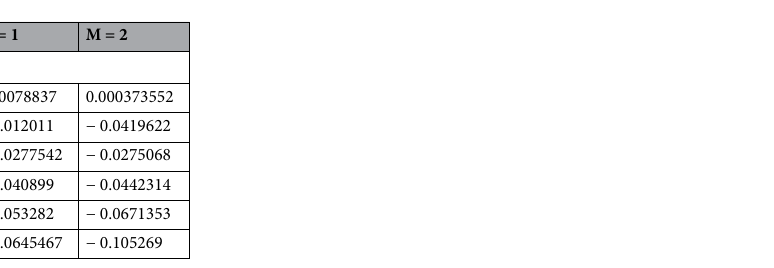
0.75 (green line) in the presence of expulsive harmonic oscillator and BOL =